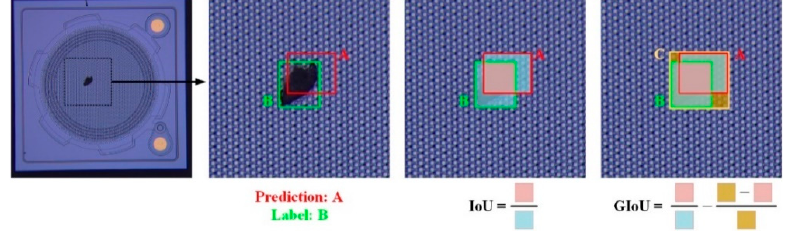
Figure 5. IoU and GIoU.